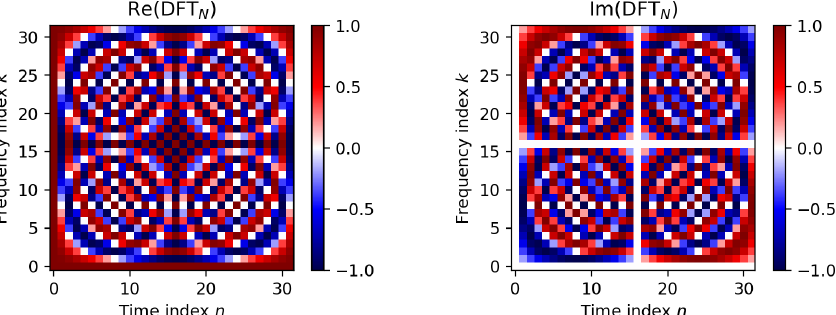
Figure 7. The matrix DFT N and a visualization of its real and imaginary parts for the case N = 32.